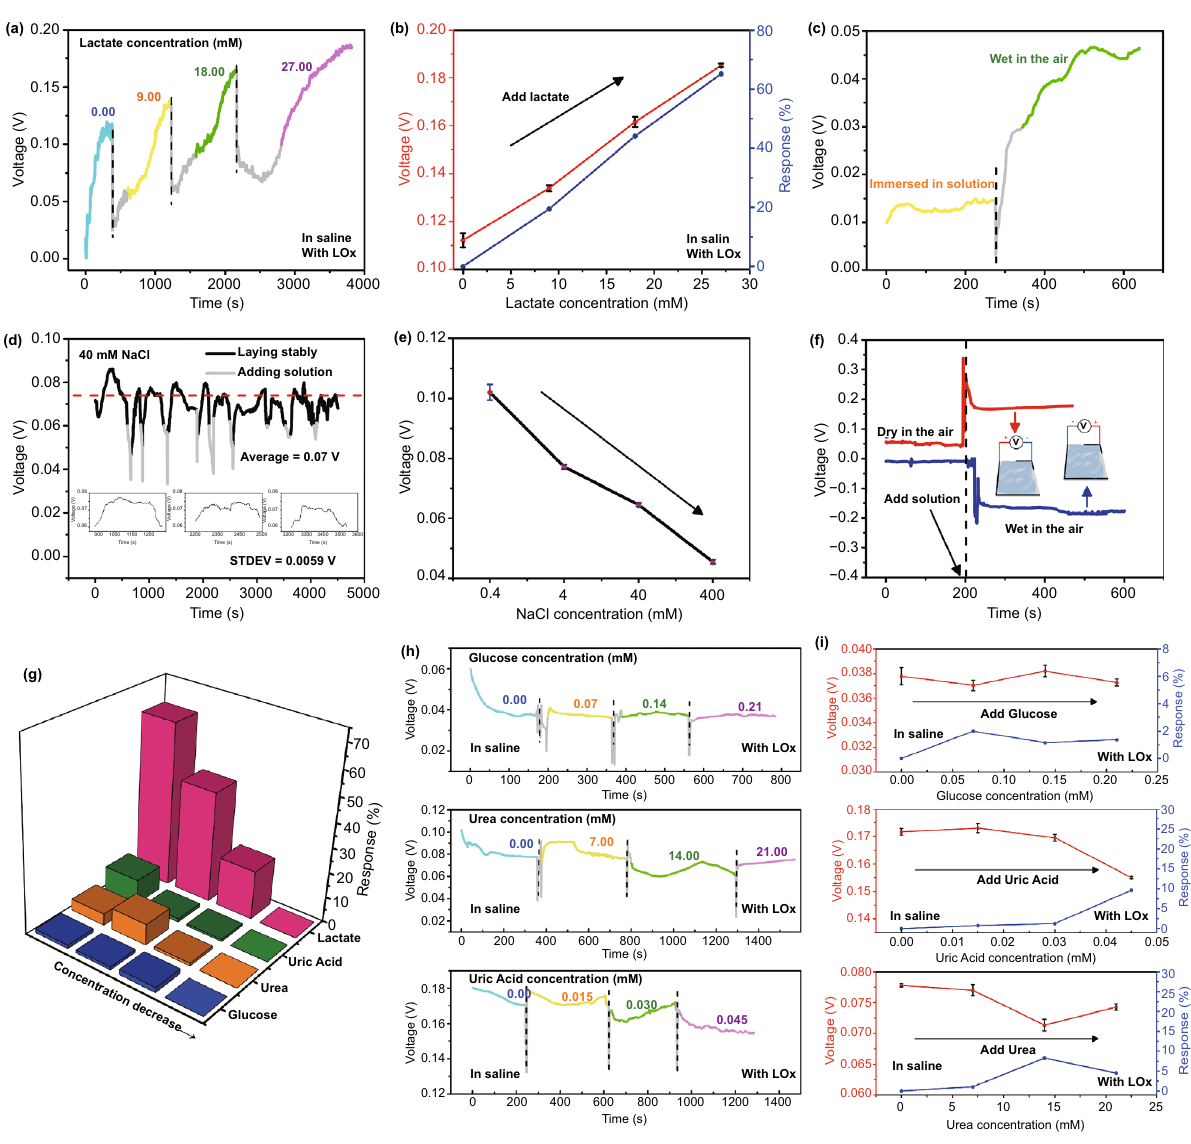
Fig. 2 a Lactate biosensing performance of the device. b Response between the outputting voltage of the device and the lactate concentration. c Control experiments of primary battery’s effects. d Stability of the device. e Effect of large gradient NaCl concentration on device outputting voltage. f Outputting voltage of the device after switching the positive and negative terminals. g – i Selectivity of the